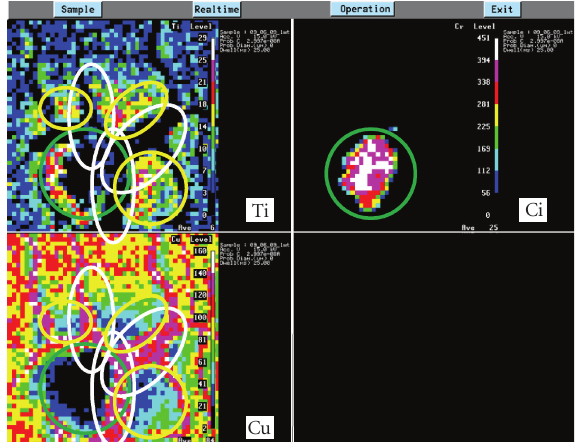
Figure 4: EPMA image of Cr-doped TiO 2 film prepared under the condition of R = 1